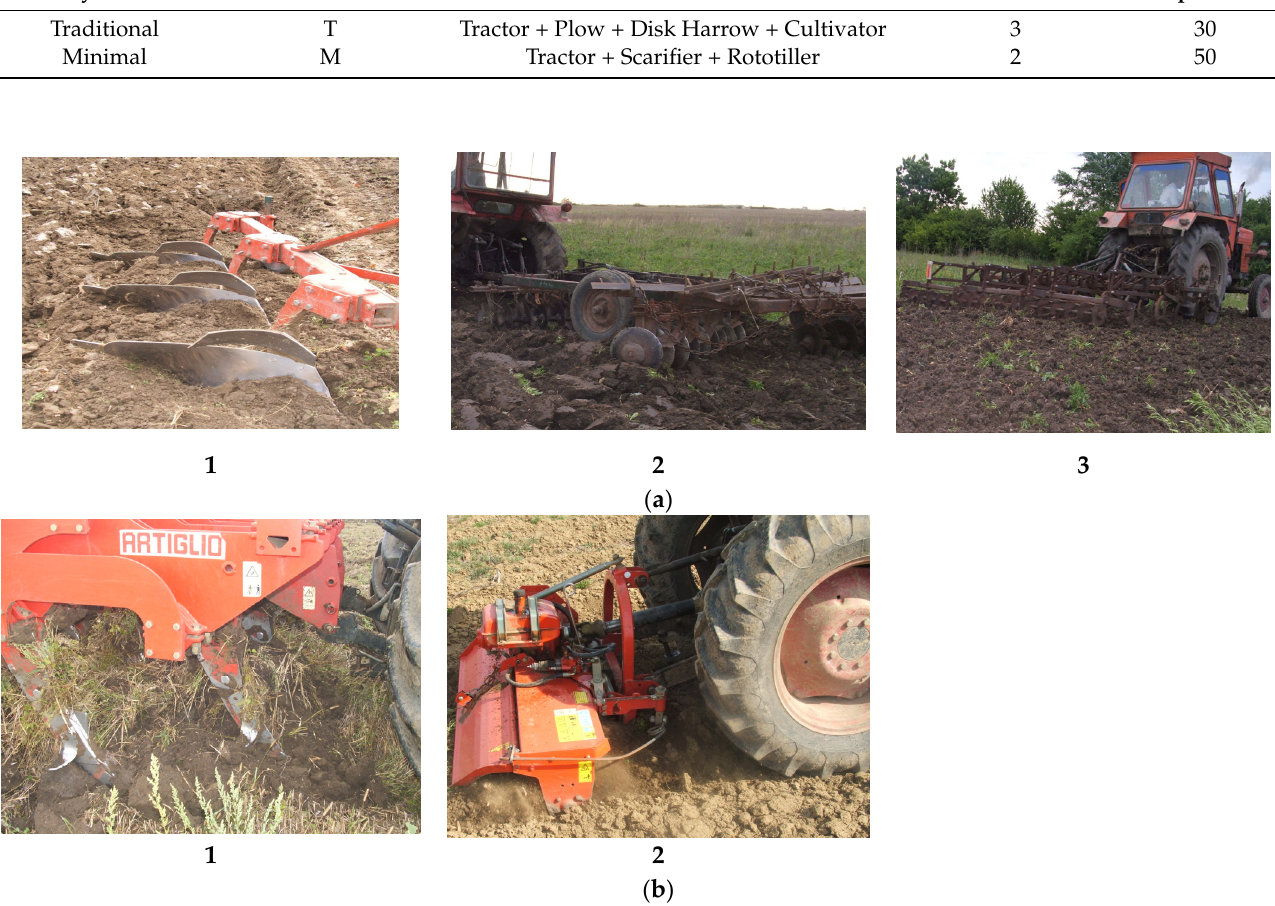
Figure 2. Description of the equipment used in the traditional ( a ) and minimal ( b ) seedbed tillage systems. Legend: ( a )—traditional seedbed tillage system: 1—plow, 2—disk harrow, 3—cultivator; ( b )—minimal seedbed tillage system: 1—scarifier, 2—rototiller.